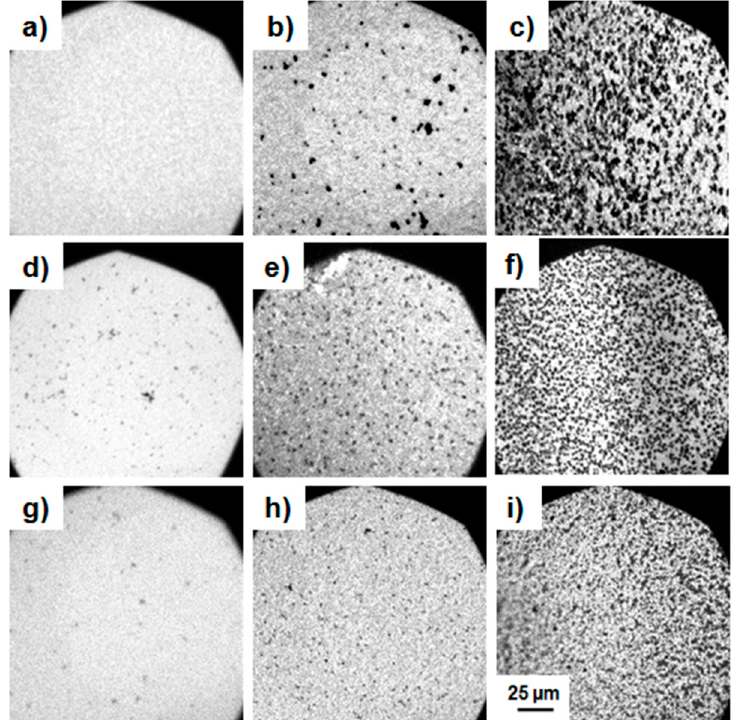
Figure 6. Epifluorescence microscopy images of monolayers of 2 ( a – c ), 6 ( d – f ), and 7 ( g – i ) at the air–water interface at 20 °C. The images were recorded at constant compression of the spread monolayer at the following surface pressures: ( a ) 4.3, ( b ) 21.0, ( c ) 28.4, ( d ) 5.0, ( e ) 15.6, ( f ) 34.4, ( g ) 0.1, ( h ) 9.2, and ( i ) 20.0 mN · m − 1